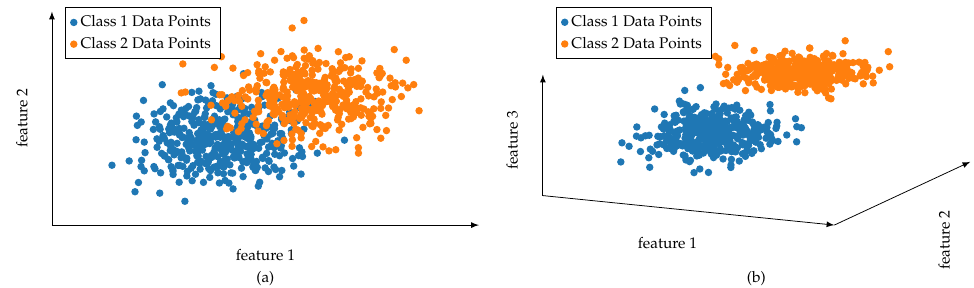
Figure 4. A classification example in which the addition of a new data source allows us to distinguish two classes perfectly ( b ). In the two-dimensional space shown in ( a ), the aleatoric uncertainty prevents a clear separation of classes. Low-dimensional data is still a form of epistemic uncertainty as it is unknown how the class distributions evolve with new